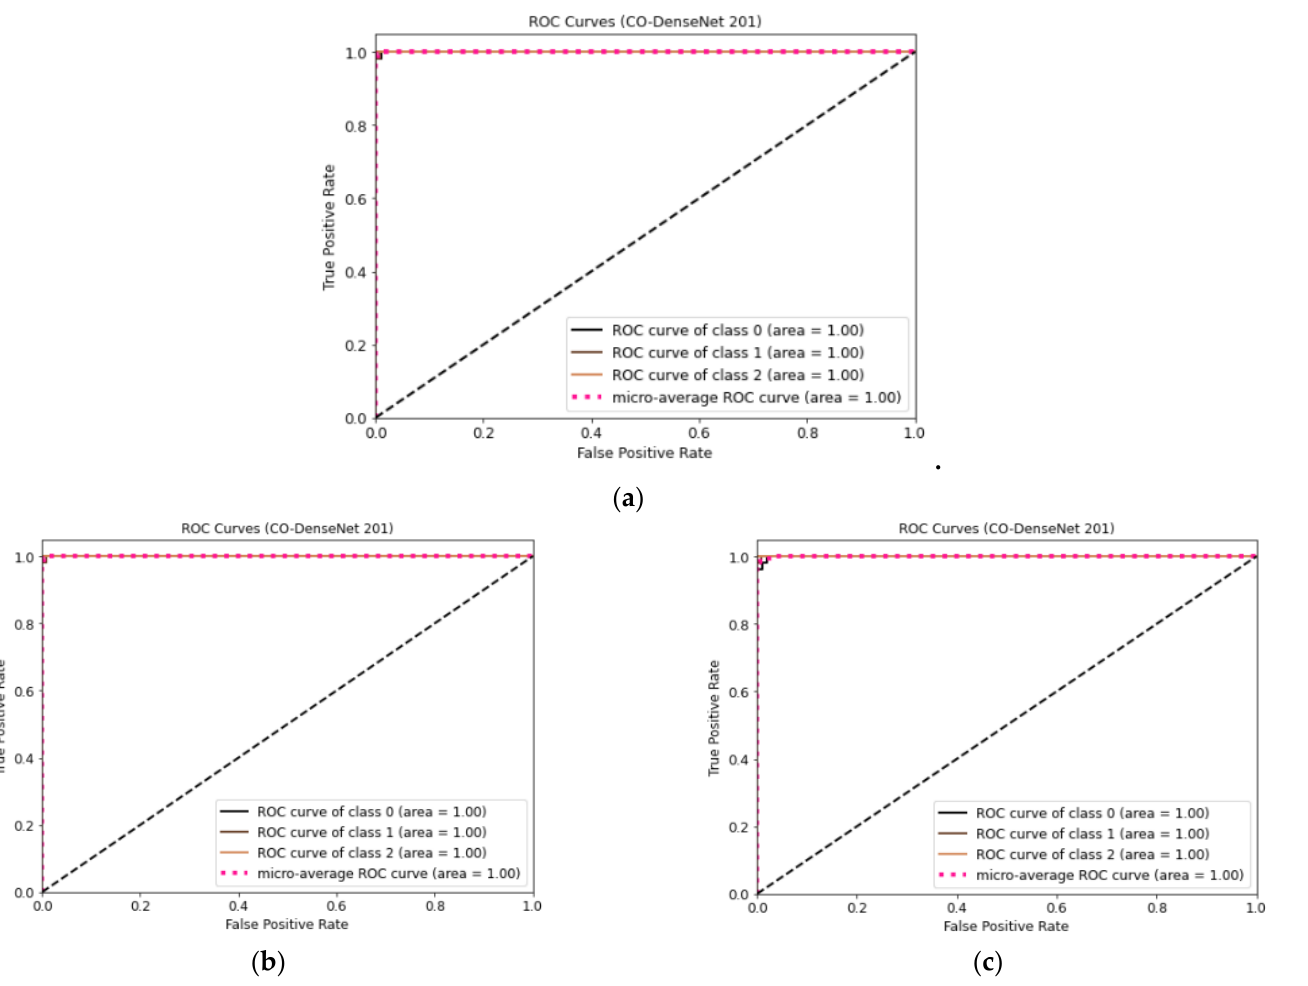
Figure 7. ( a ) ROC curve for CT images using LDDNet with Adam optimizer, ( b ) ROC curve for CT images using LDDNet with Nadam optimizer, and ( c ) ROC curve for CT images using LDDNet with SGD optimizer.